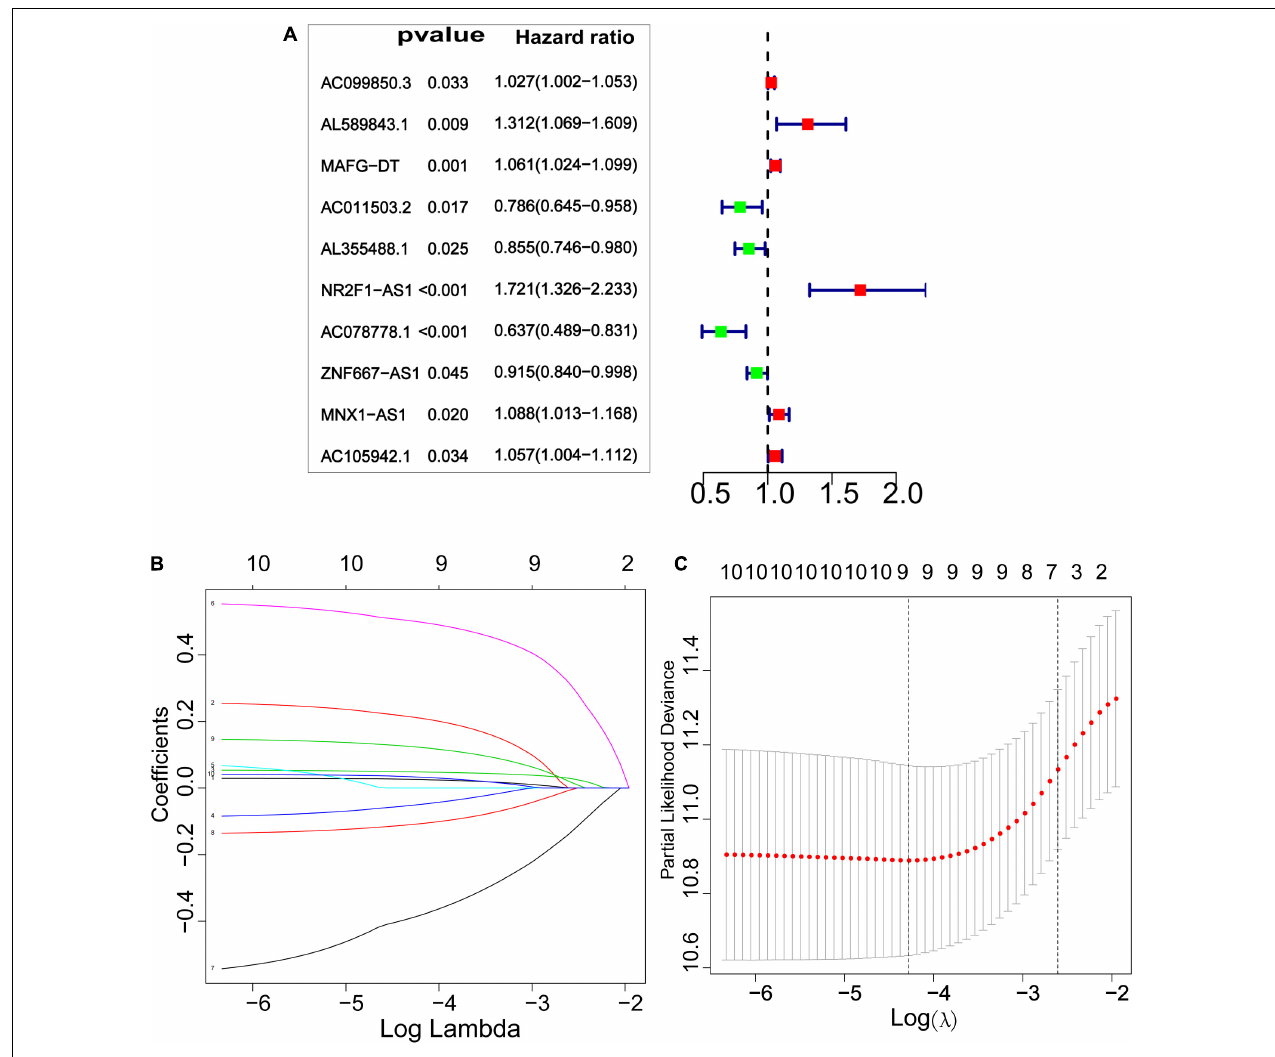
FIGURE 3 | Screening glycolysis-related lncRNAs with prognostic value. (A) Risk ratio Forest plot identified 10 glycolysis-related lncRNAs with prognostic significance ( P < 0.05). (B,C) LASSO regression further screened out 9 glycolysis-related lncRNAs that were significantly related to